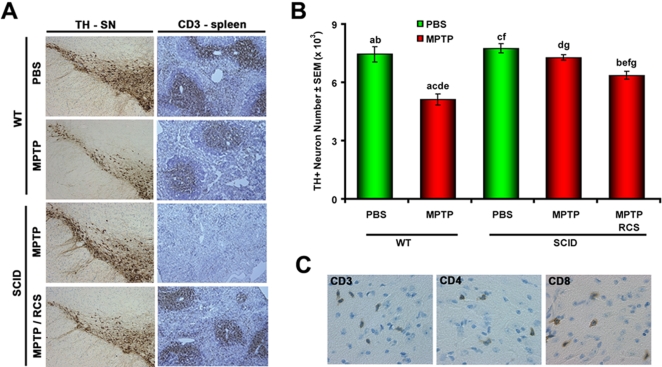
Nigral degeneration following MPTP-intoxication in B6 SCID mice before and after lymphoid cell reconstitution.(A) Photomicrographs of TH-immunostained SN (left panels) and CD3-immunostained spleen sections (right panels) from B6 (WT), SCID, and reconstituted SCID (RCS-SCID) mice treated with PBS or MPTP and obtained on day 21 post-MPTP intoxication. Immunostaining for expression of CD3 in spleens show normal distributions of CD3+ T cells in B6 WT and RCS-SCID mice treated with PBS or MPTP. Note the absence of CD3+ T cells in spleens from SCID MPTP mice. (B) Quantification of TH+ neurons in the SN of B6 WT, SCID, or reconstituted (RCS) SCID mice treated with PBS or MPTP. Values represent mean number of TH+ neurons ± SEM for 5-9 mice per group. abcdefgPair-wise comparisons by Bonferroni post-hoc test: acd
p<0.0001, bef
p<0.001, g
p<0.05. (C) Coronal VMB sections of MPTP intoxicated B6 mice reacted with antibodies against CD3, CD4 and CD8 show positive immunostaining of cells with small, round lymphocytic morphology (magnification = 400X).